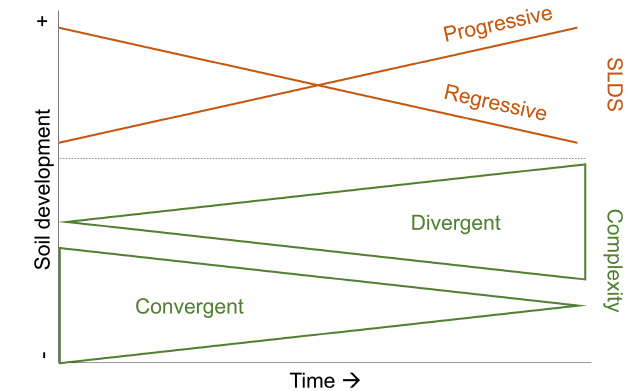
Figure 2. Illustration of evolutionary pathways related to soil- landscape development state (SLDS) and soil